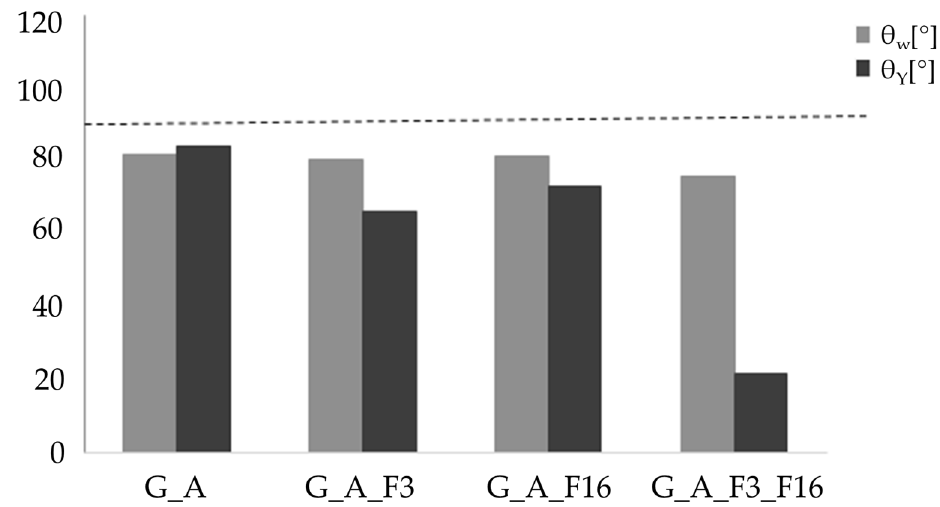
Figure 9. Comparison of contact angles θ w and θ Y of the coatings.